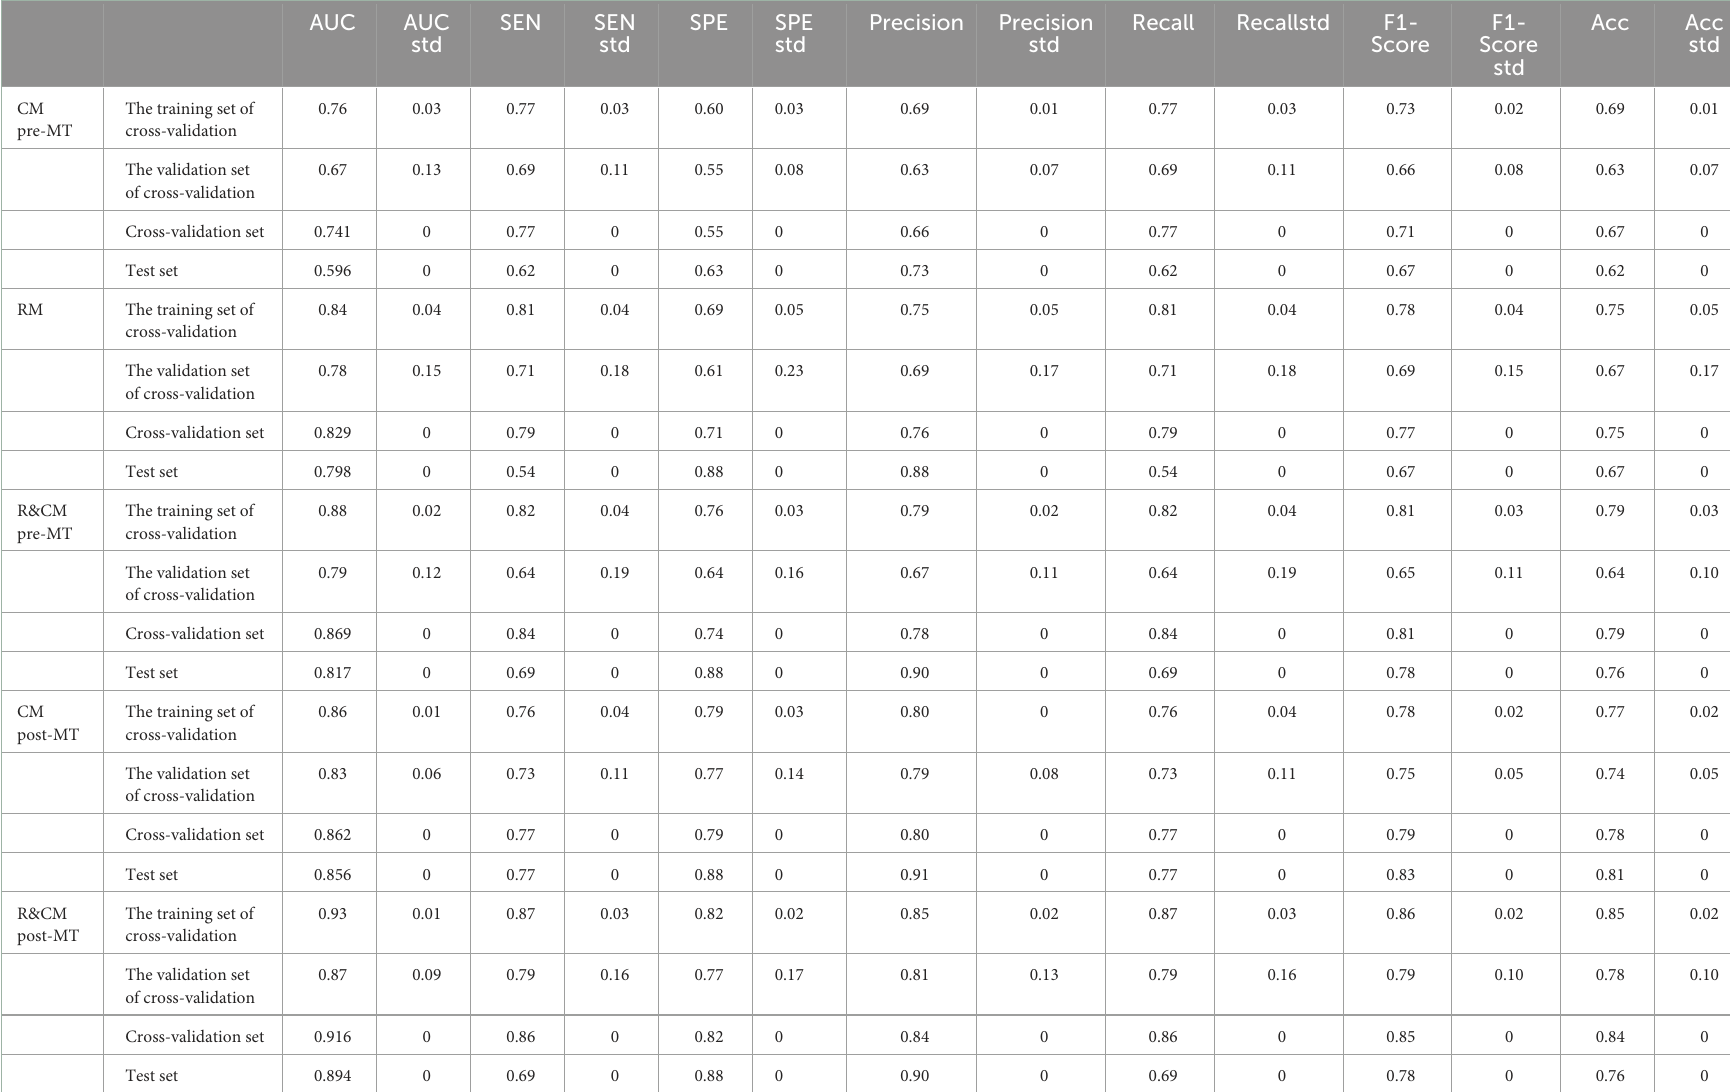
TABLE 2 The different evaluation parameters in five